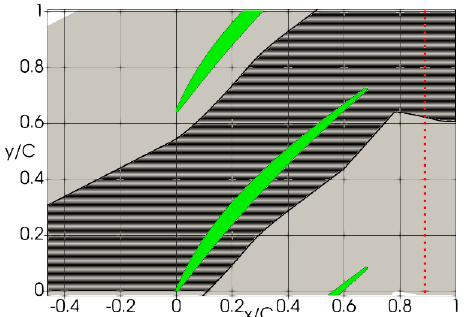
Figure 6. Top down view of the simulated linear cascade profile with zoom of the computational domain (shaded region), repeated in y-direction (grey). Coordinates are scaled using the blade chord. Red dashed line at x/C = 0.89 depicts the stage outlet plane.